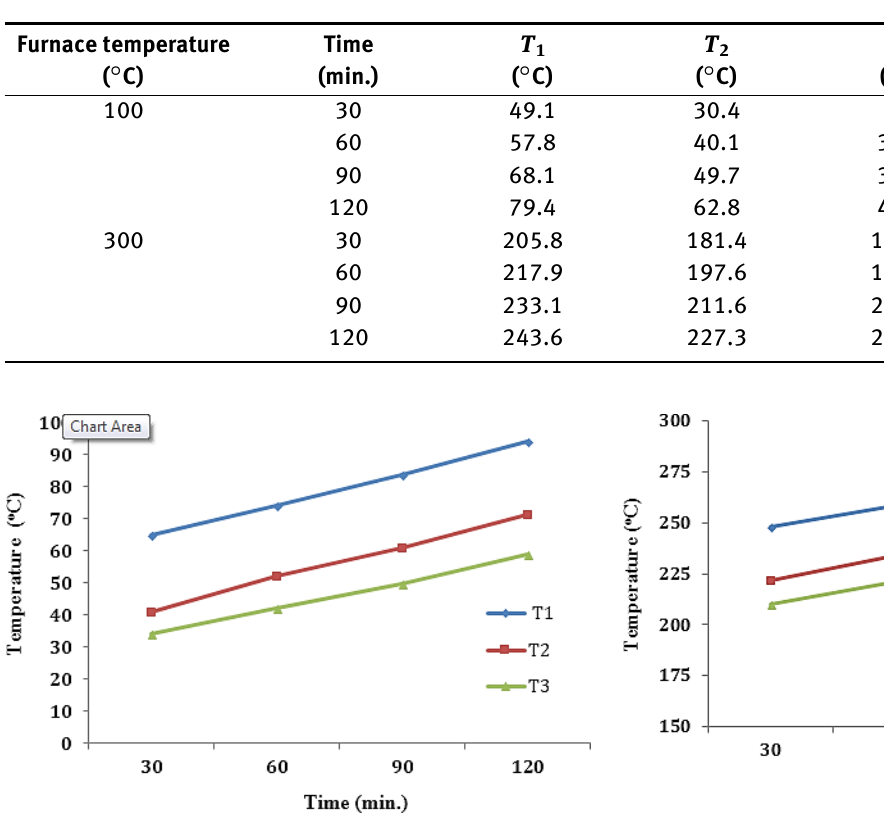
Table 4: Experimental results at different temperatures of (TiN/Al 2 O 3 /TiCN) specimen